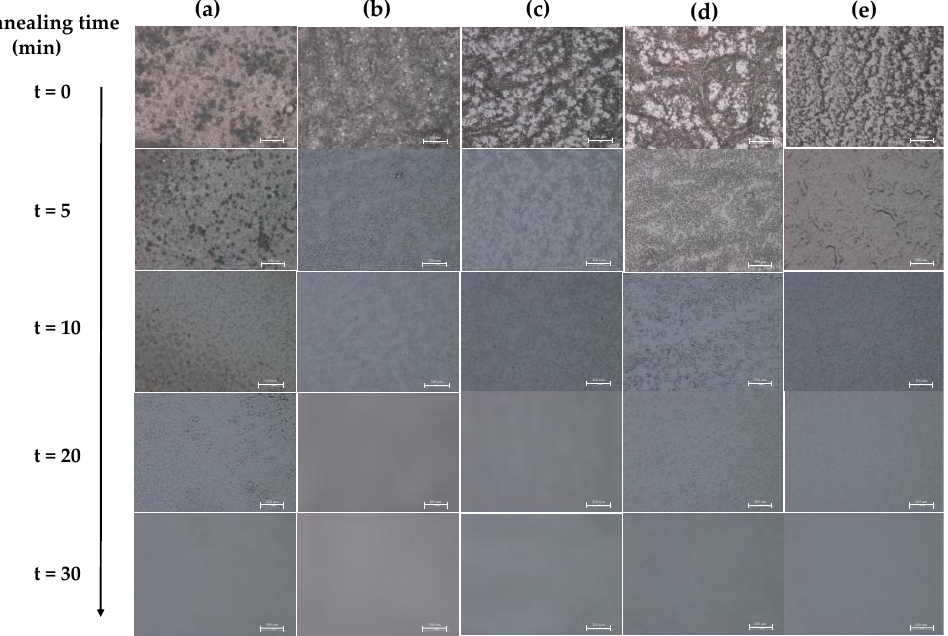
Figure 2. Optical micrographs of the phenoxy/PBT blends with various compositions annealed at 260 °C for various periods of time: ( a ) 9/1, ( b ) 7/3, ( c ) 5/5, ( d ) 3/7 and ( e ) 1/9.